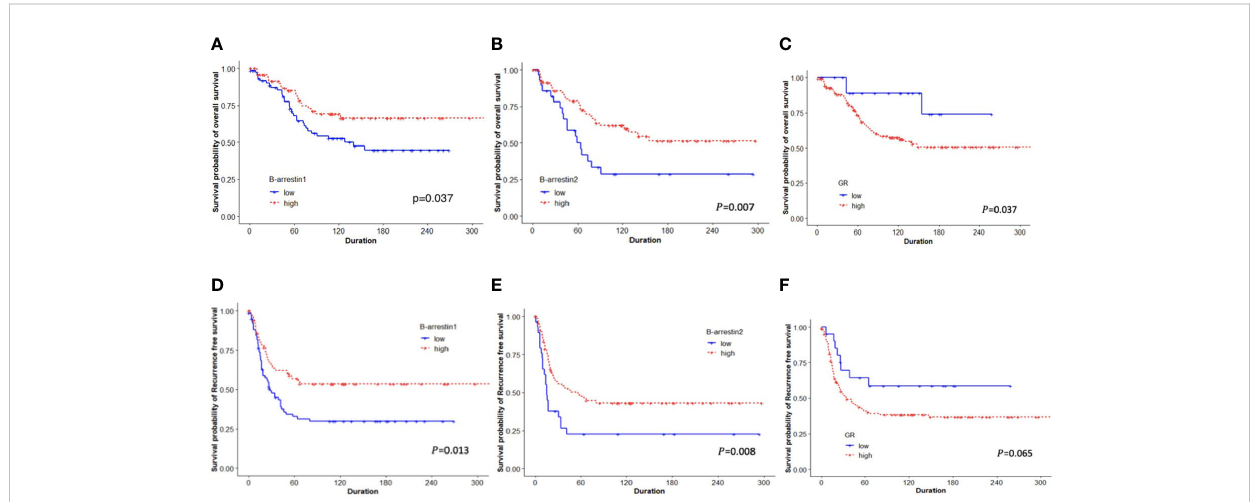
FIGURE 2 Kaplan – Meier plots for OS and RFS based on categorized b -arrestin 1 and 2 and GR expression. (A, B) , Low b -arrestin 1 and 2 expression was associated with shorter OS (log-rank P = 0.037, P = 0.007, respectively). (C, F) , Low GR expression was associated with better OS (log-rank P = 0.037), but not with RFS (log-rank P = 0.065). (D, E) , Patients with low expression of b -arrestins 1 and 2 had signi fi cantly shorter RFS than those with high expression (log-rank P = 0.013, P = 0.008).